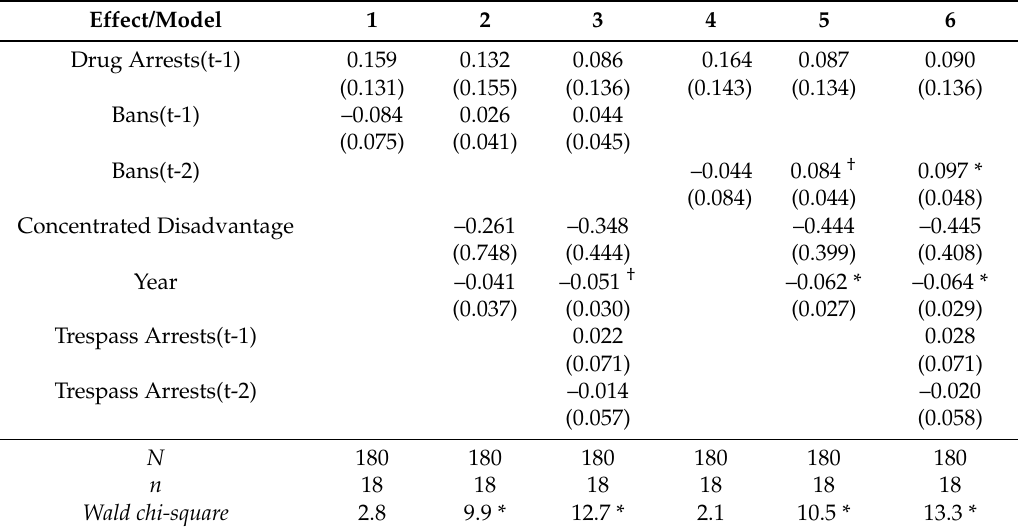
Table 6. Arellano-Bond dynamic panel-data models predicting drug